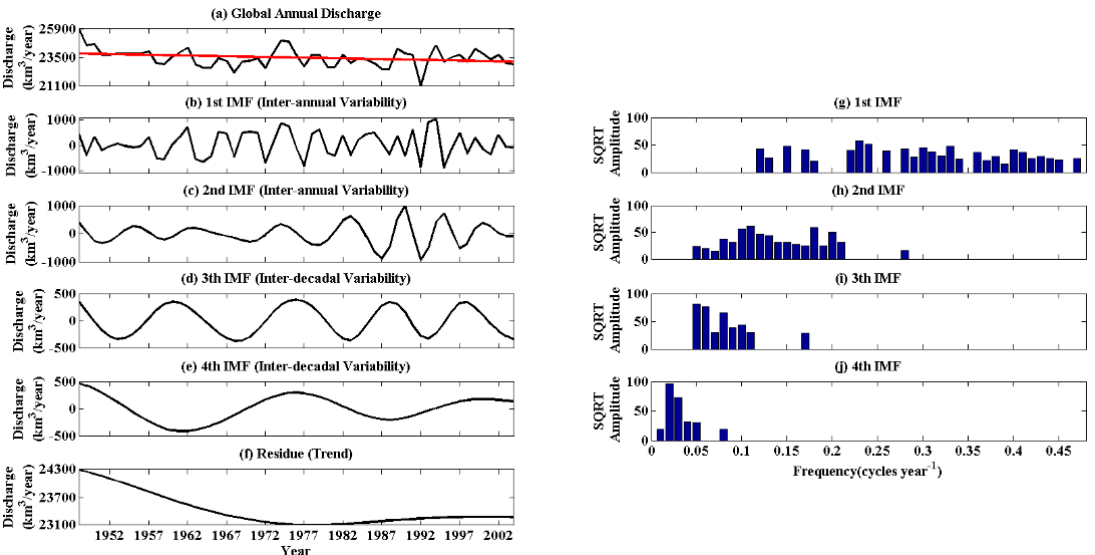
Figure 1. Annual global freshwater discharge from 1948 to 2004 ( a ), and its decomposition into four intrinsic mode functions ( b – e ) and trend ( f ) using ensemble empirical mode decomposition (EEMD). The red line in ( a ) represents the trend estimate using the Mann–Kendall (MK) method, and the power spectrum of each intrinsic mode function (IMF) is also shown in ( g – j ).